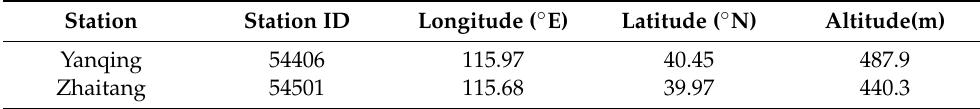
Figure 1. Geographical location of the stations in Beijing, Northeast China. Table 1. Geographical coordinates of the stations.